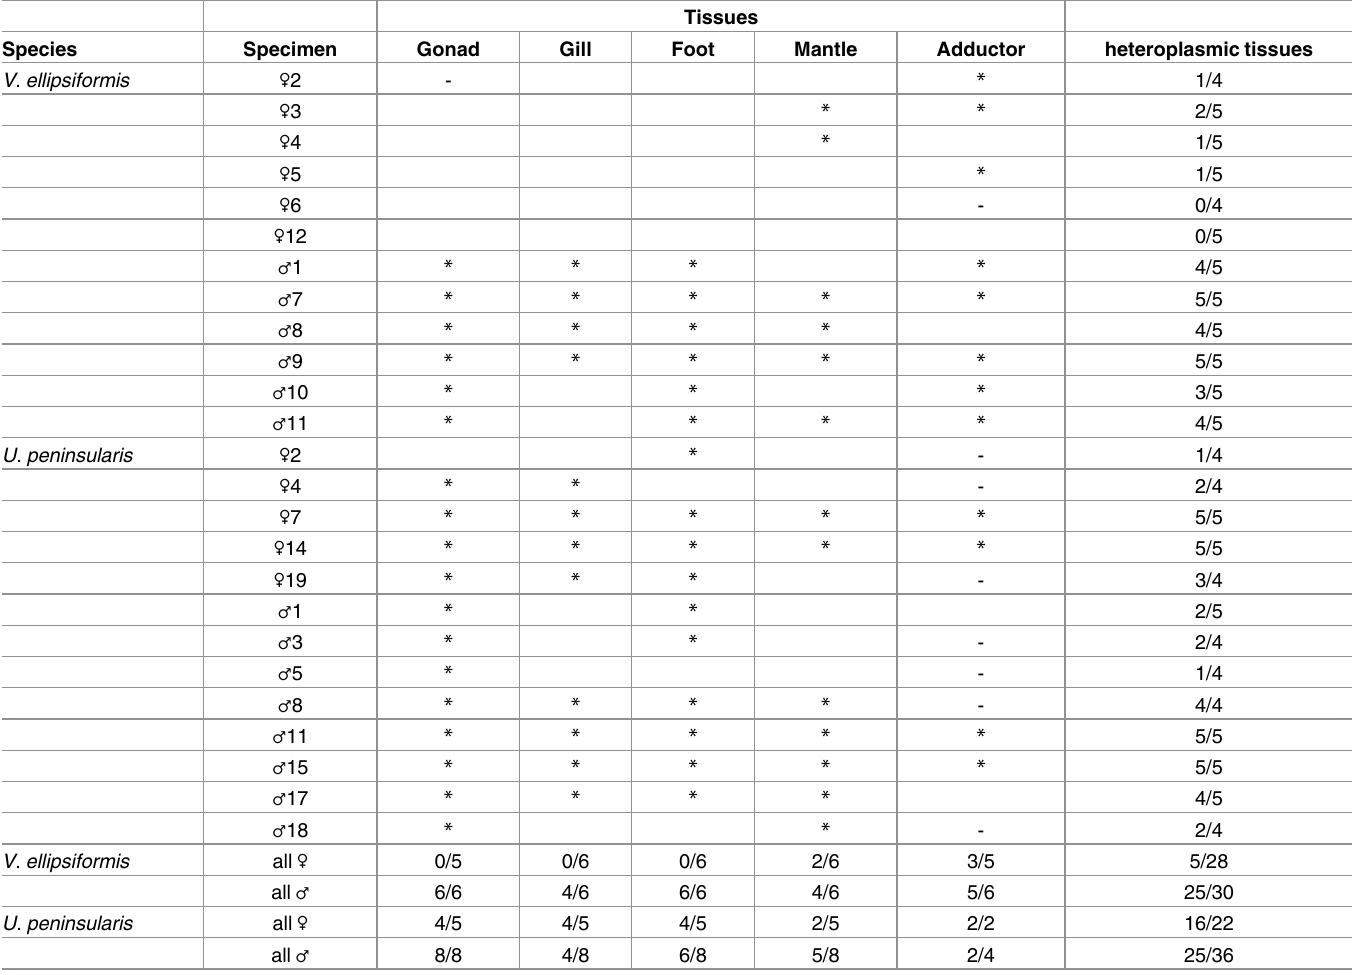
Table 2. Results of the PCR experiments on all samples tested.